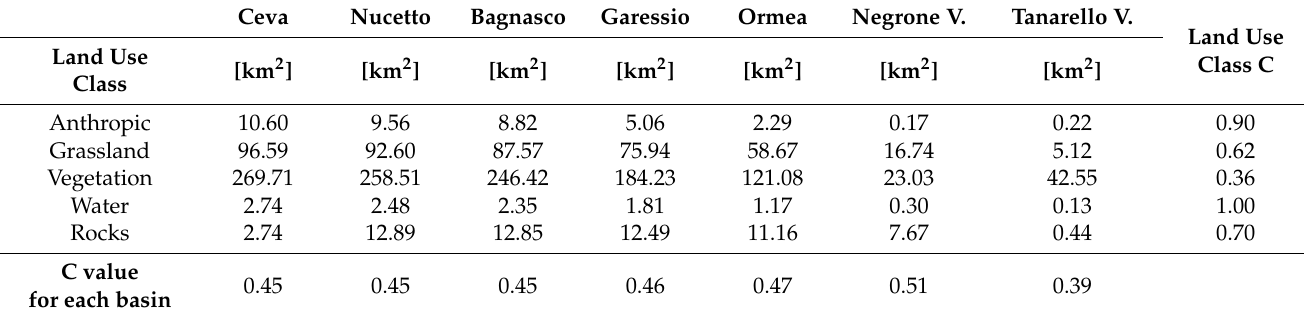
Table 3. Evaluation of the maximum expected rainfall intensity (i) according to Equation (2) for a recurrence period of 200 years, calculated for the five sub-basin of the UTV.